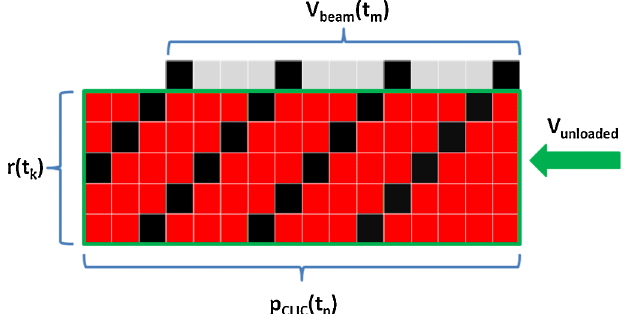
FIG. 13. Loaded voltage calculation: full convolution multi- plications (red squares), multiplications necessary to calculate the voltage seen by the beam (black).